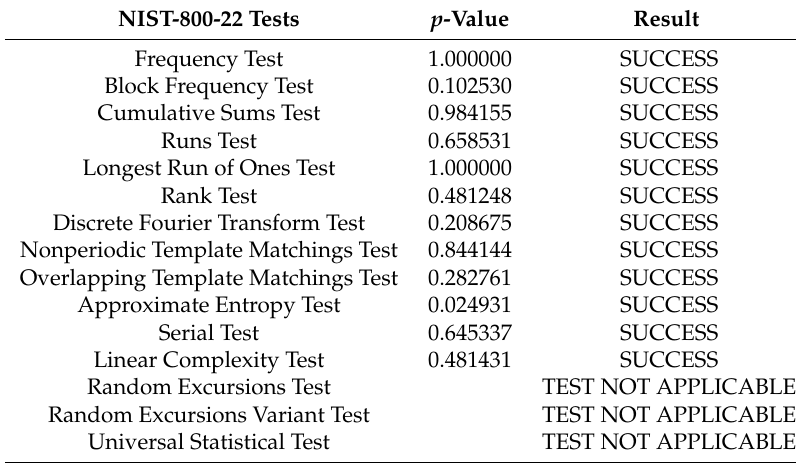
Table 2. NIST-800-22 test results of the obtained